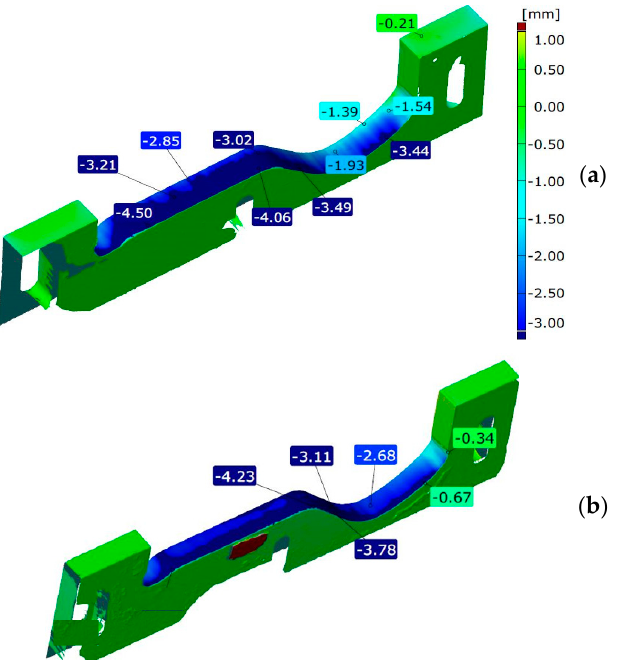
Figure 6. Results of scanning the upper tools made of steel: ( a ) Hardox 600 and ( b ) NC11LV.